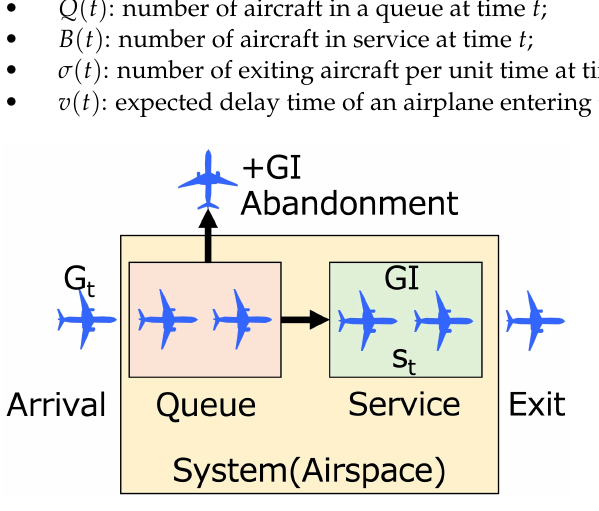
Figure 1. Conceptual diagram of the G t / GI / s t + GI queuing